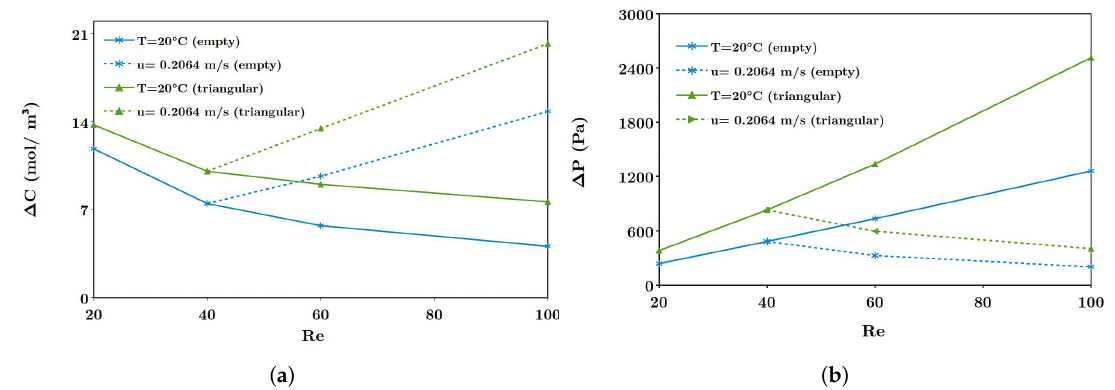
Figure 14. ( a ) Comparison of concentration difference between inlet and outlet of the channel as a function of temperature or inlet velocity for the flat and triangular spacer-filled channel. ( b ) Comparison of pressure difference between inlet and outlet of the channel as a function of temperature or inlet velocity for the flat and triangular active spacer-filled